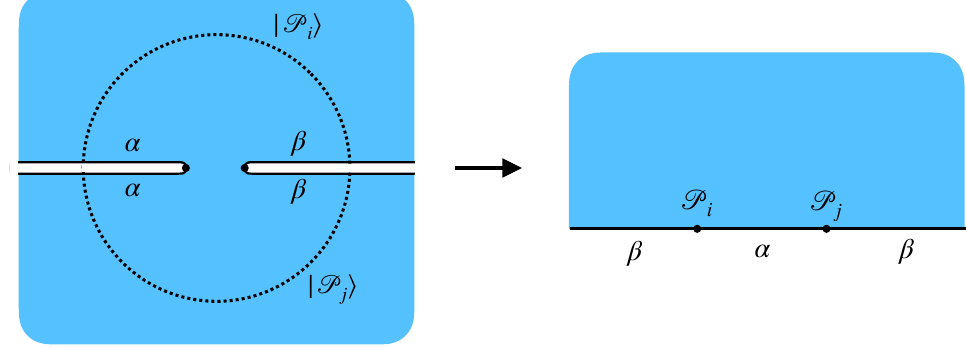
Figure 3. The overlap of the t-channel initial state with the state |P i i ⊗ |P j i ∈ H αβ ⊗ H αβ is equal to the boundary two-point function h β P i α P j β i ∼ δ ij